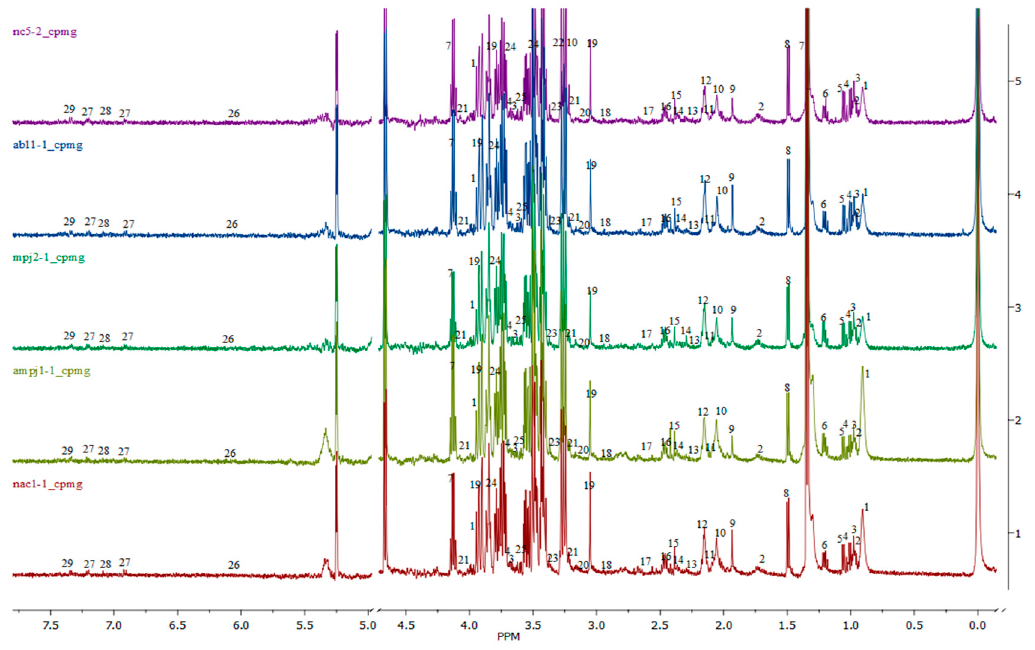
Figure 6. Overall 1 H NMR spectra of the rat serum samples obtained from all groups: (1) pantothenate, (2) leucine, (3) valine, (4) isoleucine, (5) isobutyrate, (6) 3-hydroxybutyrate, (7) lactate, (8)